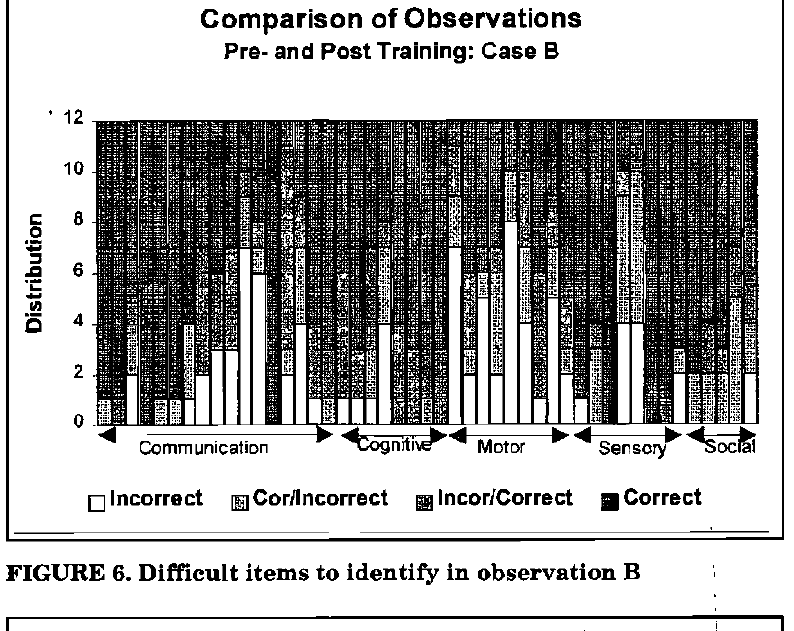
FIGURE 6. Difficult items to identify in observation Β